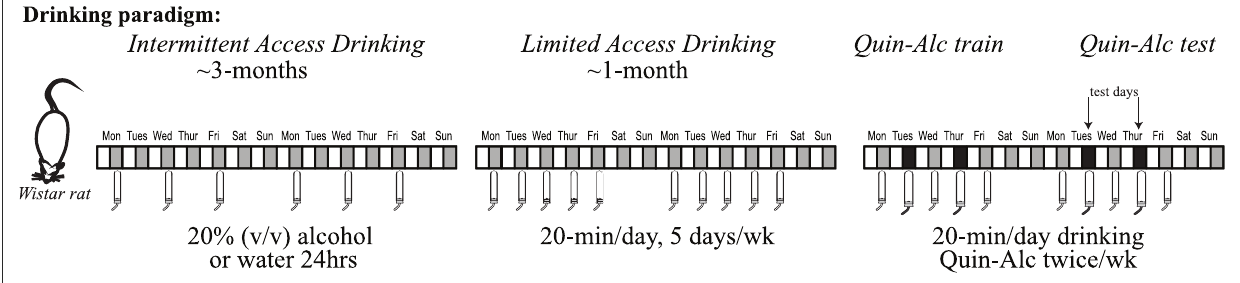
FIGURE1 Intermittent two-bottle choice, access to alcohol, paradigm. Wistar rats have access to alcohol (20% v/v diluted in water) in the intermittent two-bottle choice paradigm. Briefly, three times a week (starting Monday, Wednesday and Friday around start of the dark cycle), rats have an 18–24h period where alcohol is available concurrently with water. The alcohol and water bottle positions are alternated across days to prevent a position bias. Intermittent access continues for ∼ 12 weeks, since longer-term intake is necessary to facilitate development of aversion-resistant alcohol intake. After ∼ 3 months of intermittent access, rats are then shifted to Limited Daily Access two-bottle choice, with 20min access to 20% alcohol or water Monday through Friday. After at least 2–3 wk limited daily access, rats have 2–3 alcohol-quinine sessions per quinine dose used to habituate to the novelty of quinine in alcohol. Experimental testing of quinine-resistant alcohol drinking then begins, typically with 2 test sessions per